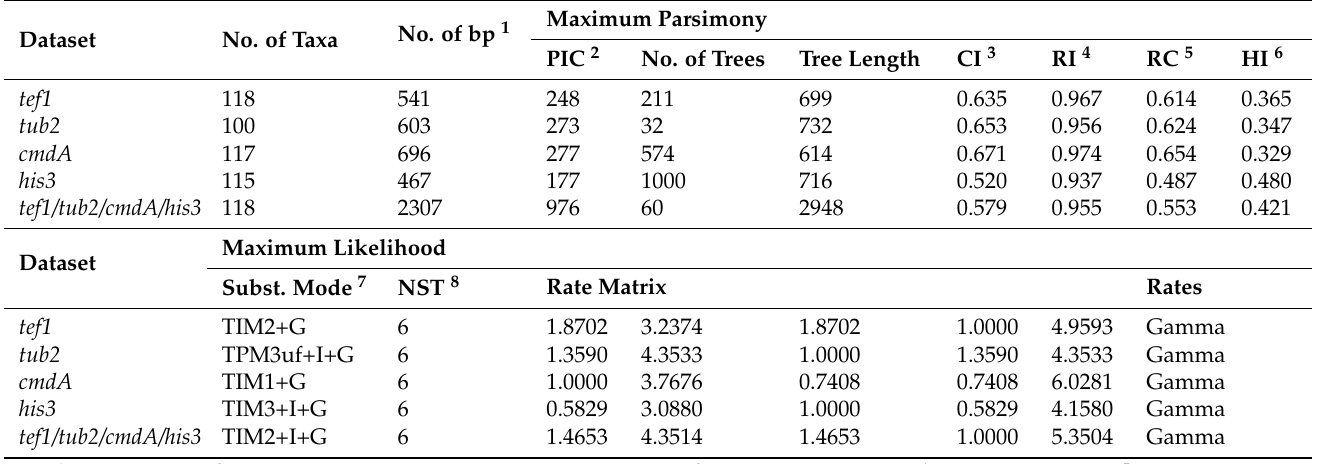
Table 3. Statistical values of datasets for maximum parsimony and maximum likelihood analyses in this